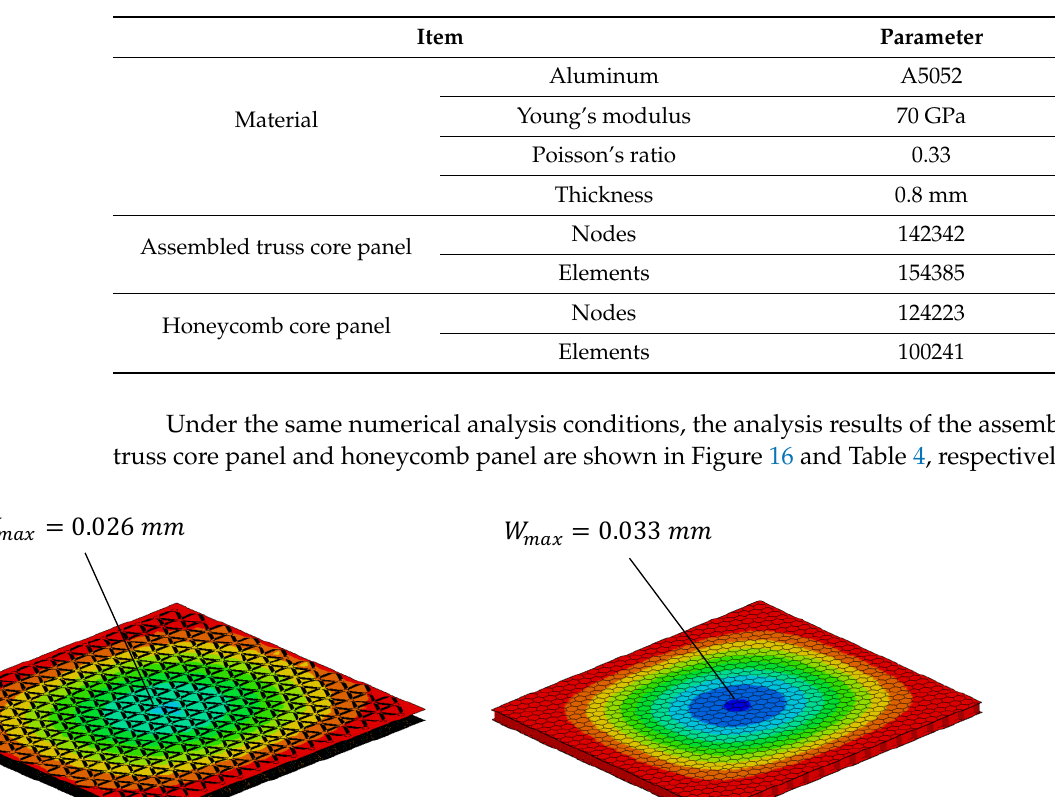
Figure 15. FEM analysis model of assembled truss core panel and honeycomb panel. Table 3. Detailed parameters of FEM analysis model.